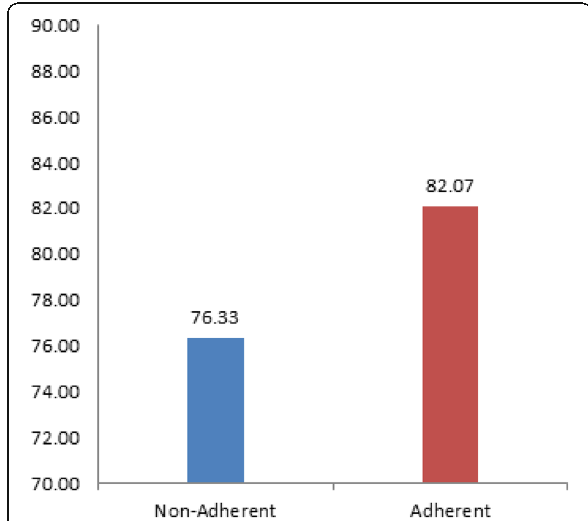
Fig. 2 Patients ’ mean treatment satisfaction scores (%) according to their